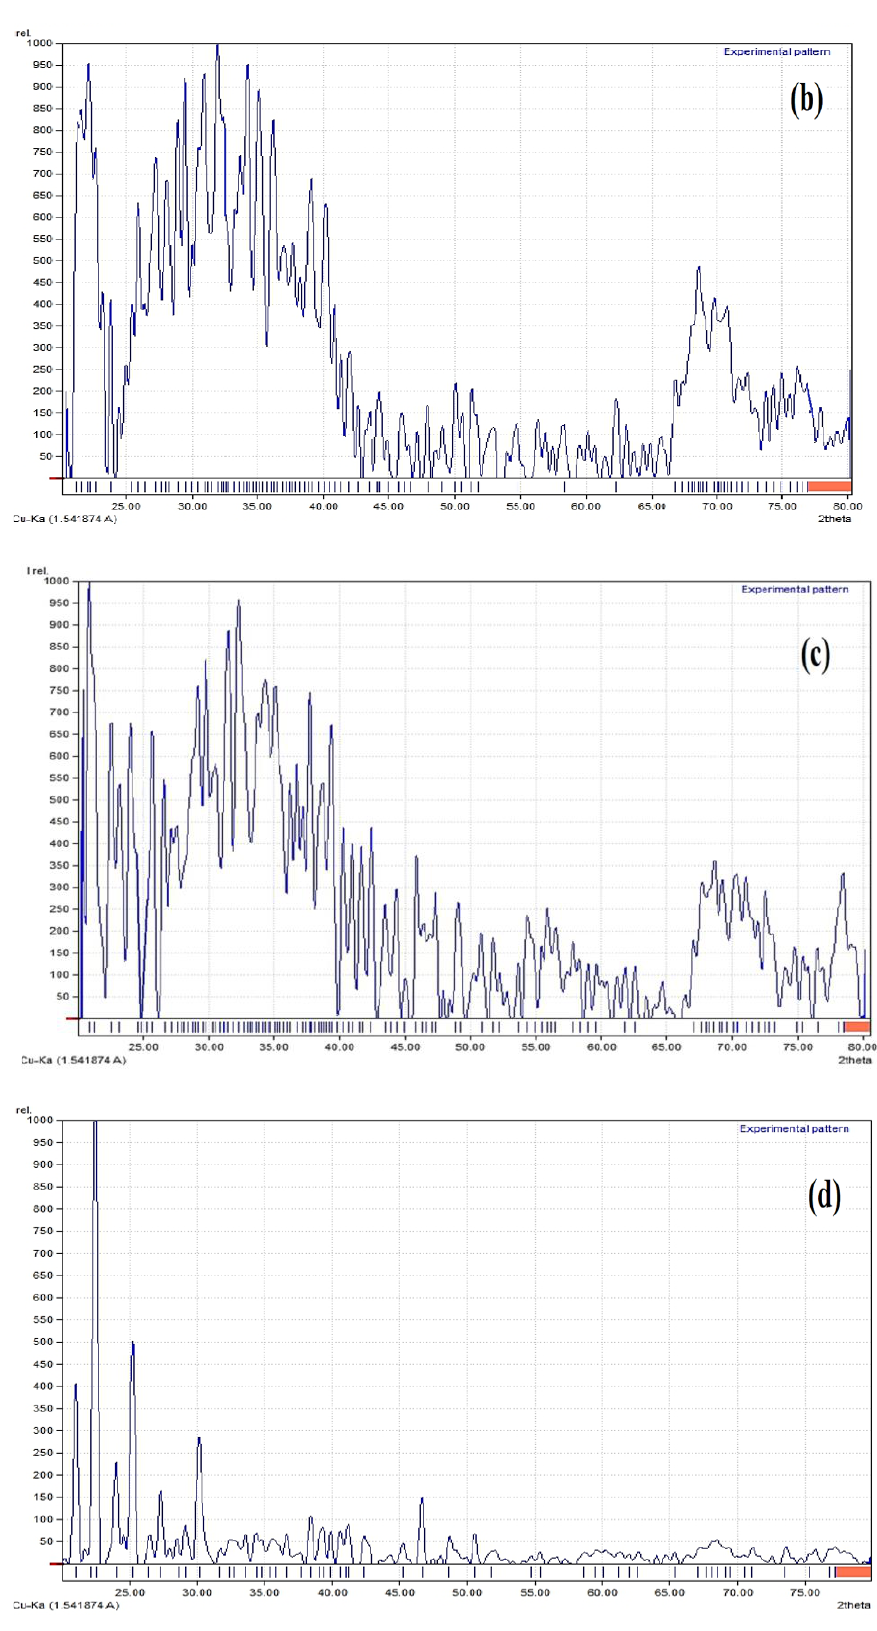
Figure 10. XRD spectra of drug, polymer, physical mixture and nanoformulation ( a ) bergenin; ( b ) EL 100; ( c ) lyophilized nanosuspension; ( d ) physical mixture of bergenin + E L100.